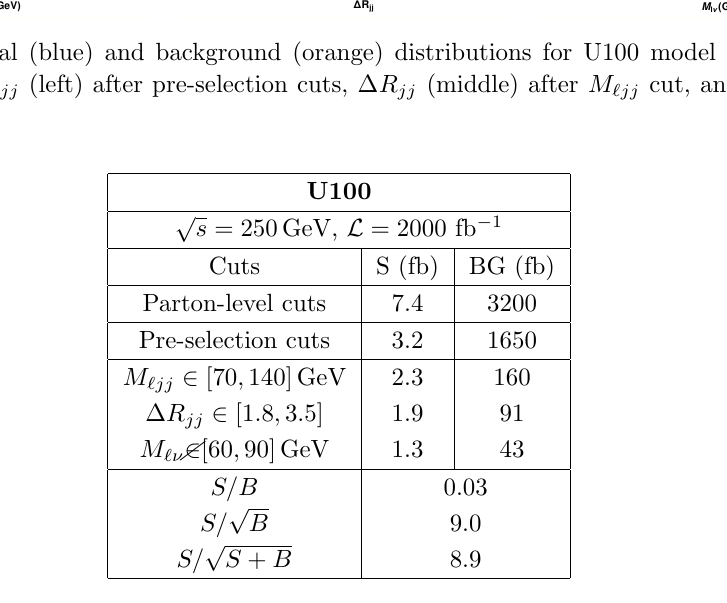
Table 6 . Cut (cid:13)ow table for the search for CW neutrinos at the U100 benchmark point, in e + e (cid:0) collisions at p s = 250